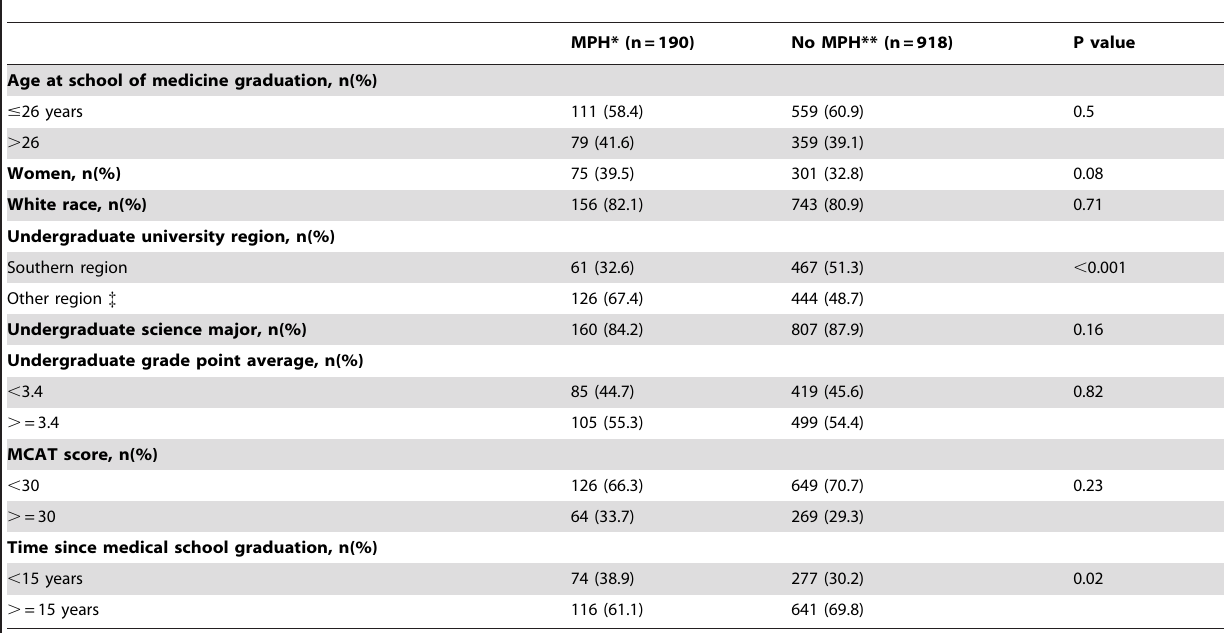
Table 1. Baseline Characteristics According to MPH Education Completion among Medical School Graduates.